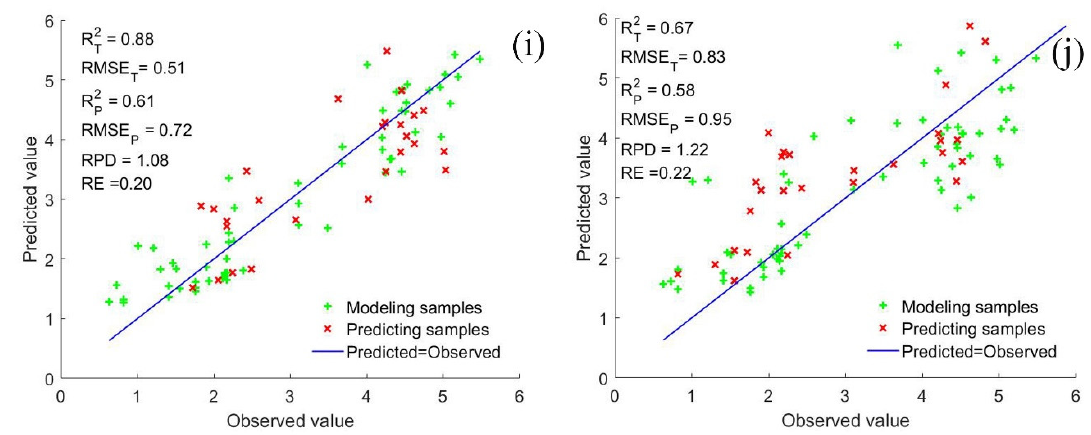
Figure 5. Inversion results. ( a ) Original _SC, ( b ) Original _PC, ( c ) Baseline1 _SC, ( d ) Baseline1 _PC, ( e ) Baseline2_SC, ( f ) Baseline2_PC, ( g ) Envelope _SC, ( h ) Envelope _PC, ( i ) LR, and ( j ) PLSR.